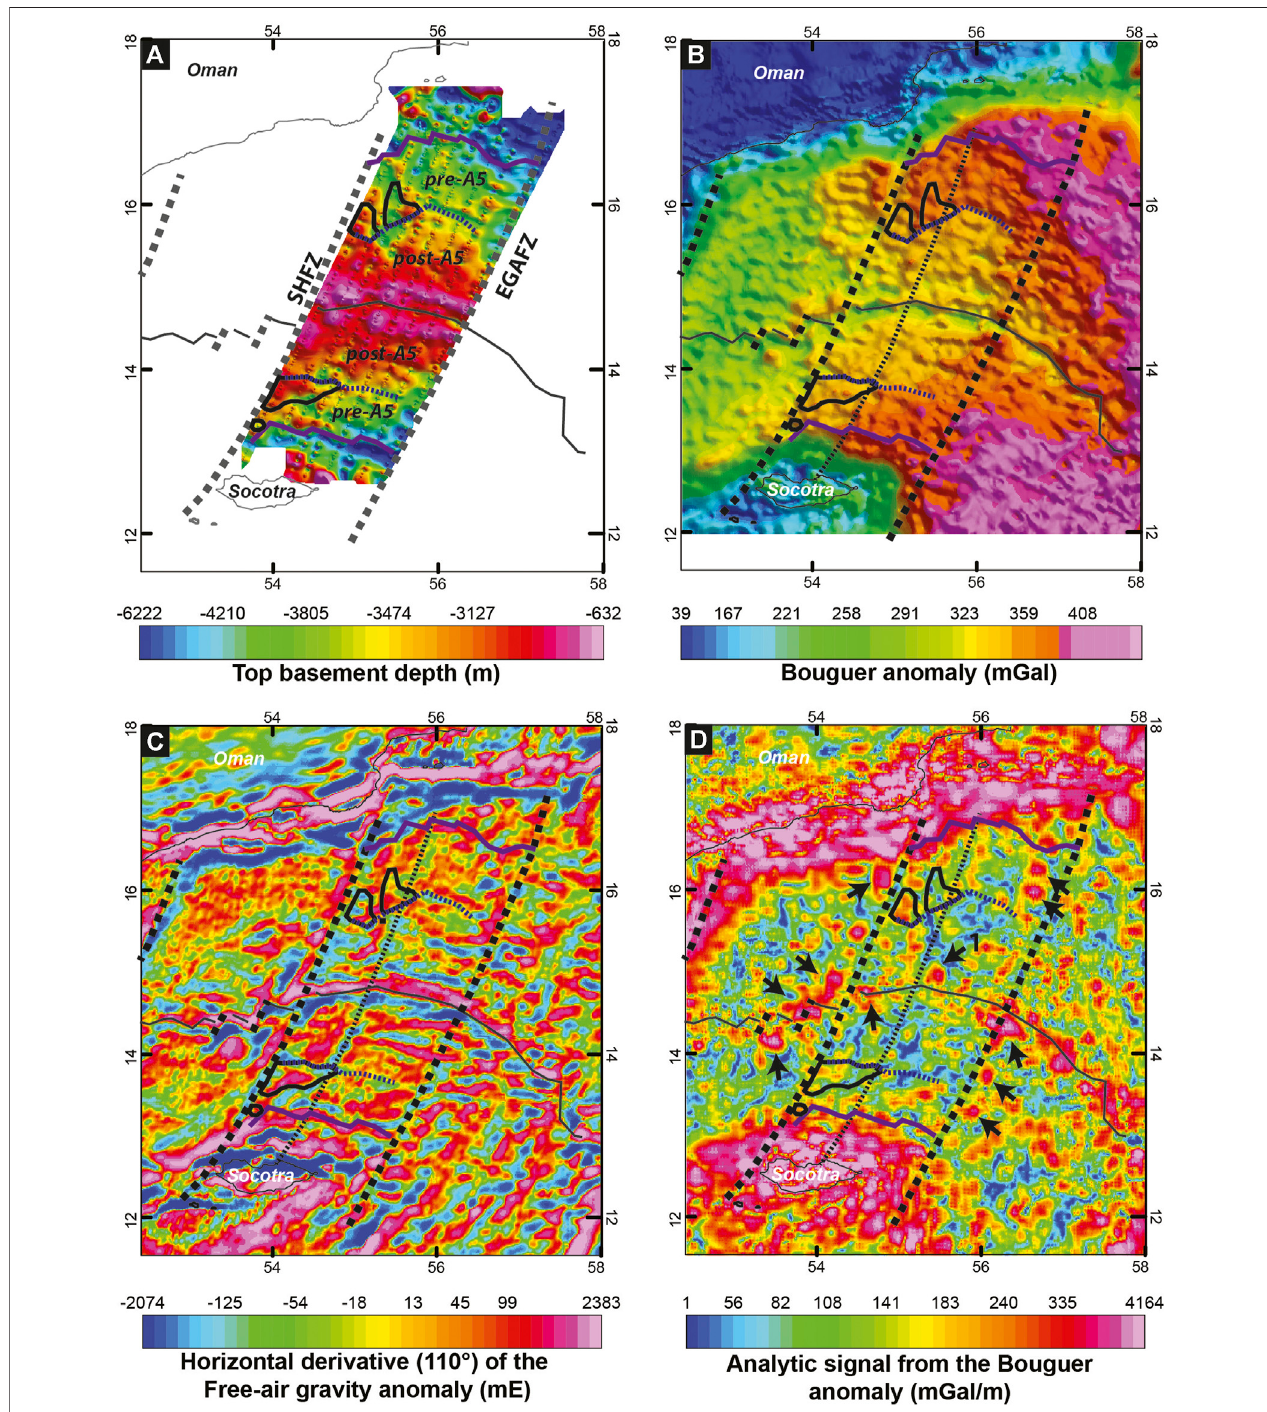
FIGURE 3 | (A) Top basement depth map from seismic pro fi les; (B) Bouguer anomaly map; (C) First horizontal derivative of the free-air gravity anomaly map (from Sandwell and Smith,2009); (D) Analytic signal calculatedon theBouguer anomaly map. Arrows pointtopatches ofhigh Bouguer anomaly values.Thin dotted blackline represents the area of thin oceanic crust interpreted as the Hadibo Fracture Zone (see the discussion). OCT termination shown in thick violet (modi fi ed from Nonn et al., 2017). Thick doted lines are the known fracture zones (SHFZ and EGAFZ). Areas outlined in black represent the smooth and regular basement subdomain described in the text.